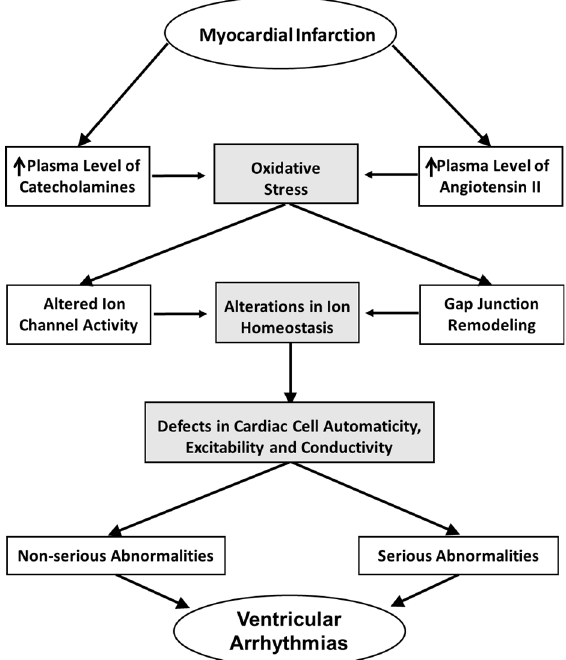
Figure 3. A scheme showing the role of high circulating levels of both angiotensin II and catecholamines in the generation of oxidative stress and subsequent events leading to the development of ventricular arrhythmias associated with acute myocardial infarction.